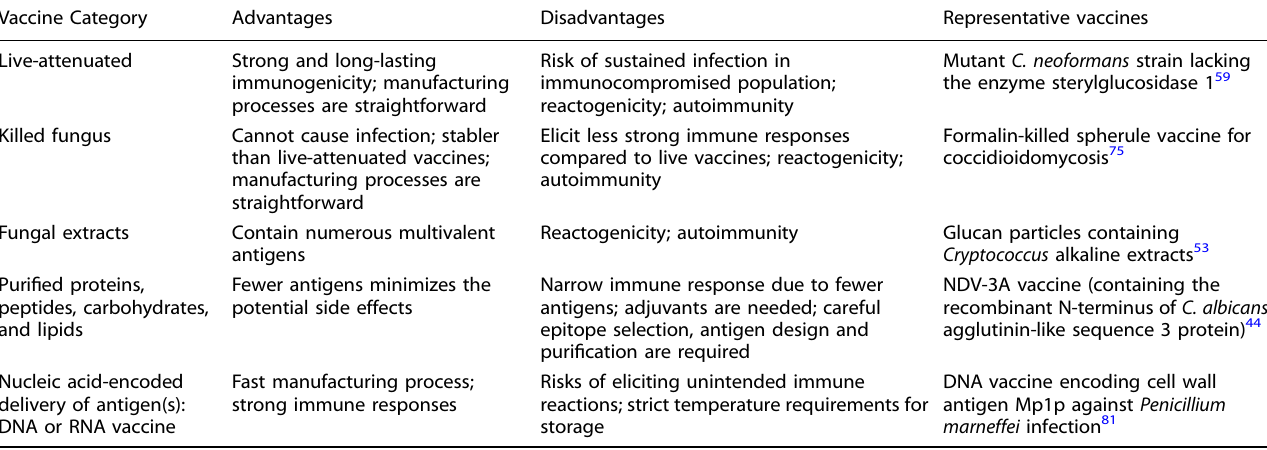
Table 3. Overview of the advantages and disadvantages of the major fungal vaccine categories.